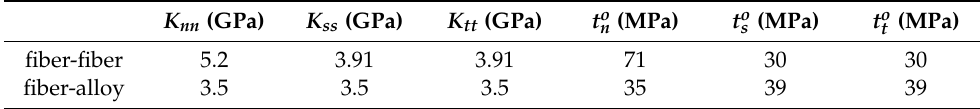
Table 3. Material parameters [24].